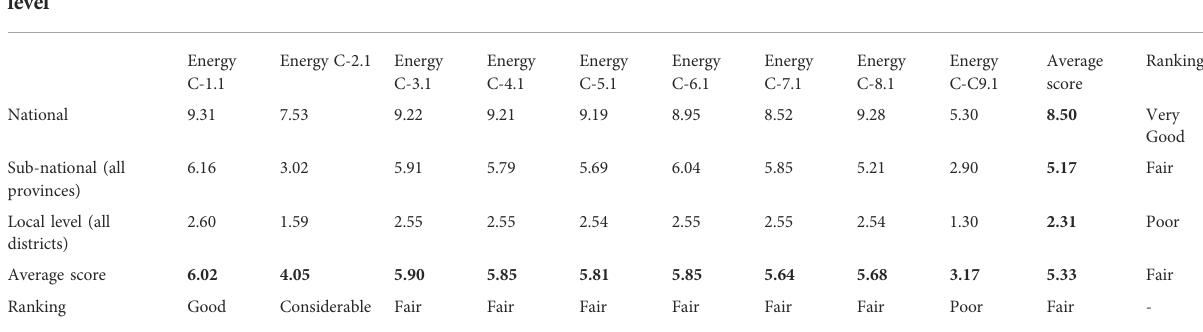
TABLE 2 Governance index for Governance Component-1 for the energy sector of Pakistan. Constituency